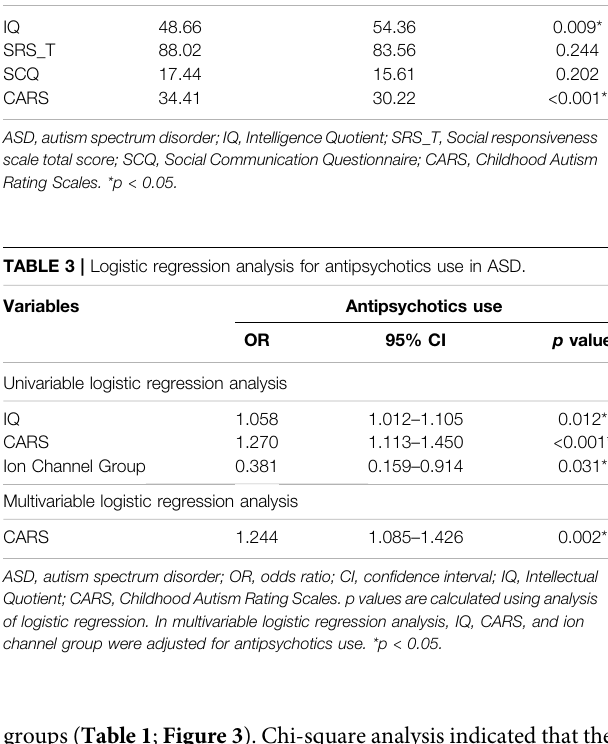
groups ( Table 1 ; Figure 3 ). Chi-square analysis indicated that the ion channel group and medication use were signi fi cantly related ( p (cid:1) 0.035). On the other hand, children with ASD who were on